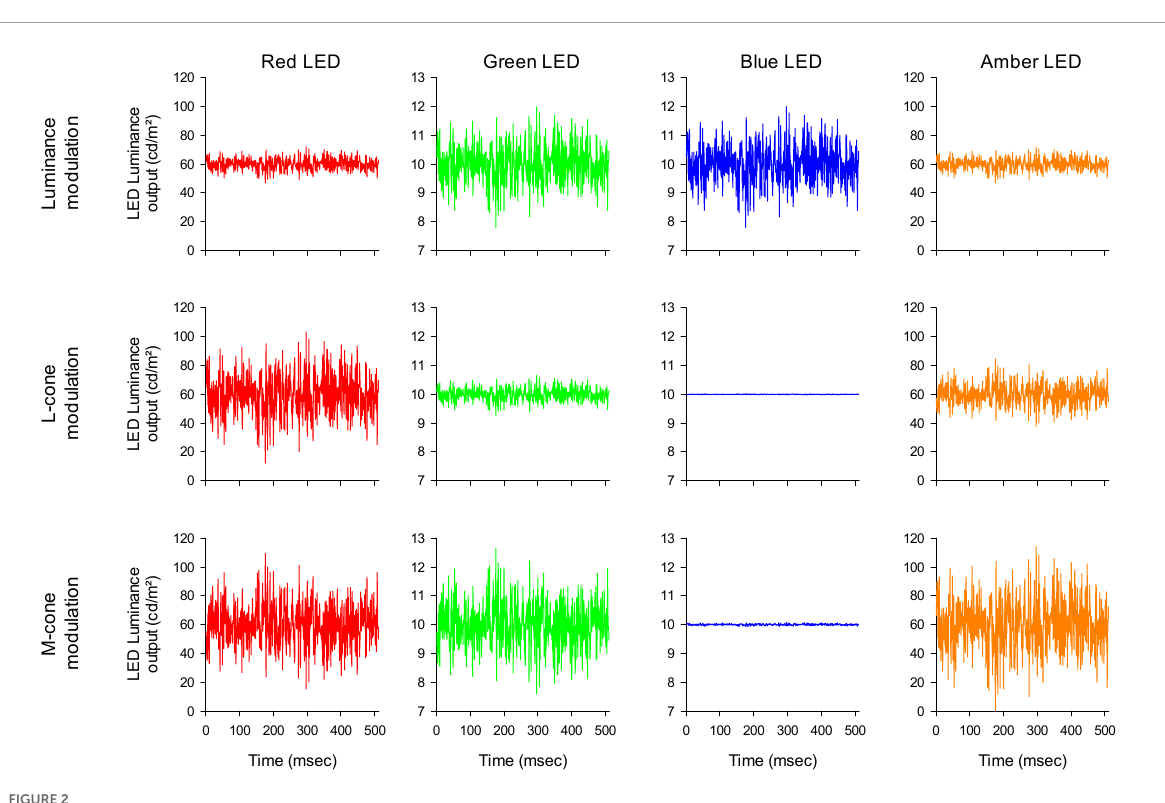
human 10 degree cone (Stockman et al., 1993) and rod (V’ λ ; Wyszecki and Stiles, 1982) fundamentals of normal trichromats were used to calculate the L- and M-cone isolating stimuli according to the triple silent substitution paradigm (Kremers, 2003; Cao et al., 2015; Huchzermeyer and Kremers, 2016,